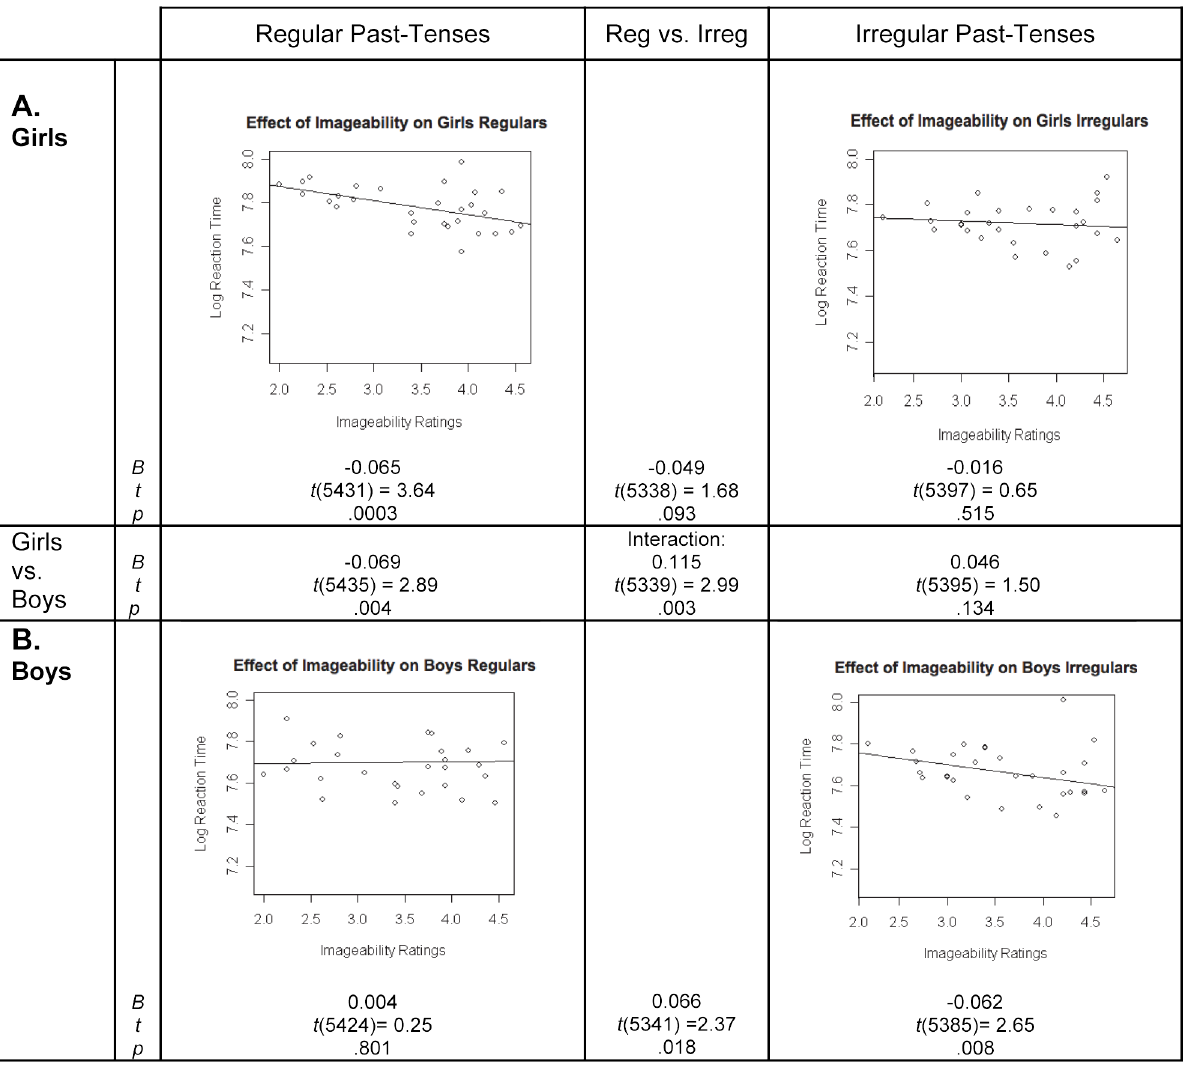
Figure 2. Children’s imageability effects for regular and irregular past-tense forms, by sex. In each scatterplot, the line represents the prediction of the mixed effects regression model with regard to the effect of imageability on the natural logarithm of response times, with the effect of all covariates removed. Points on the graph represent residuals from the model (with the effects of the covariates removed) for the 29 regular and 29 irregular verbs. B represents the unstandardized regression coefficient, indicating the slope of the regression line, t represents the t -statistic of the comparison between B and zero, and p represents the statistical significance of this comparison. (Figure 2). For frequency effects, the sex by verb-type interaction was not significant, though over both verb types, girls but not boys showed frequency effects.